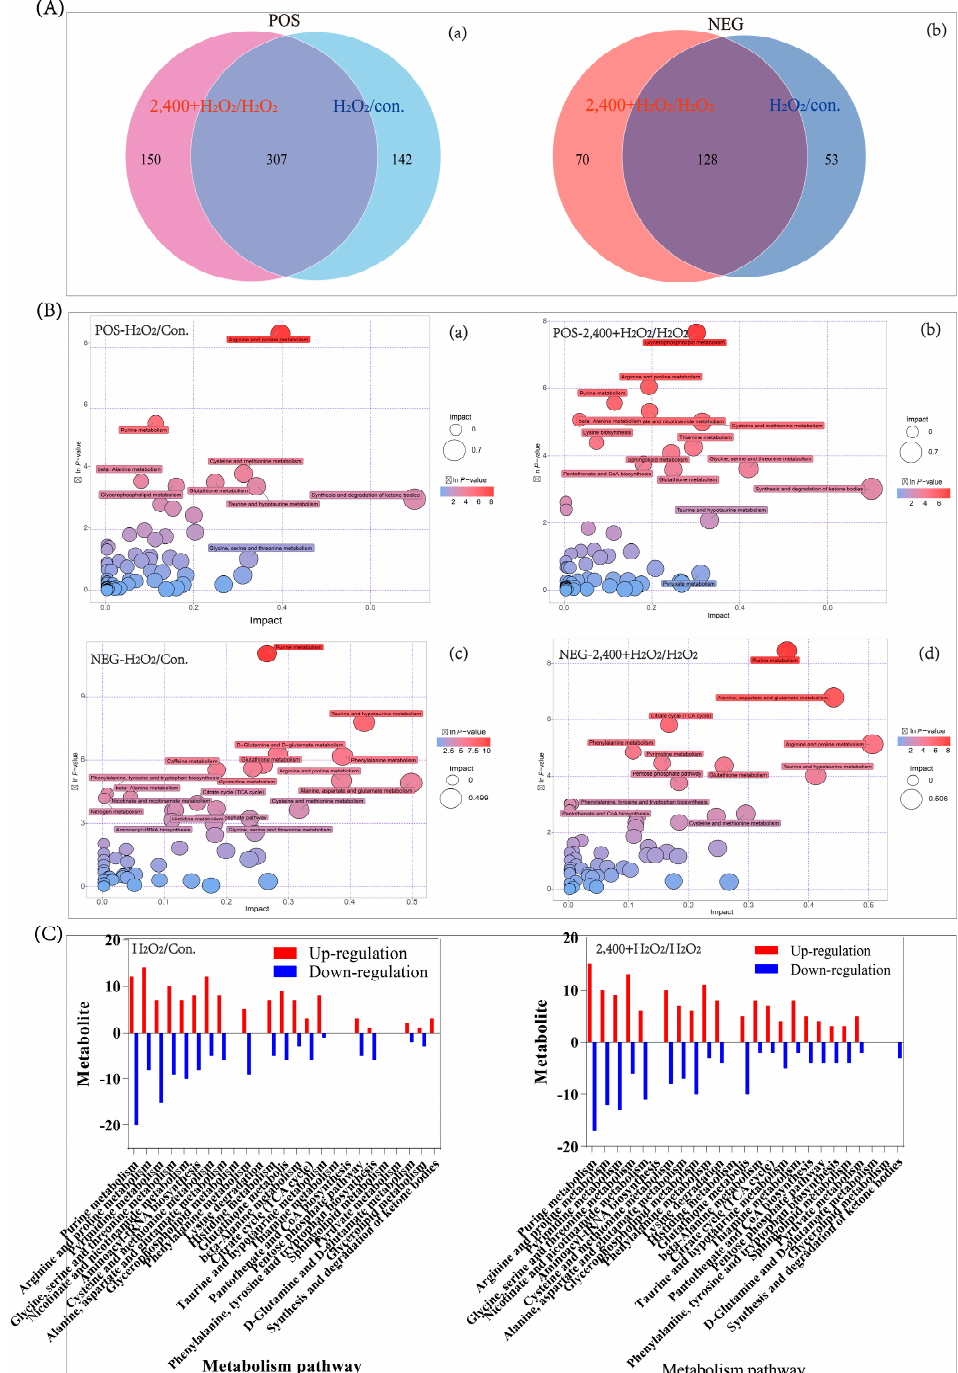
Figure 6. Metabolic pathway analysis. ( A ) Venn diagram showing differential metabolites of H 2 O 2 /Con. and chrysanthemum extract/H 2 O 2 . ( B ) Bubble plot showing the differential metabolic pathway enriched by metabolites. ( C ) Bar chart showing the differential metabolic pathway en- riched by metabolites. POS: data achieved from positive ion mode of mass spectrum; NEG: data achieved from negative ion mode of mass spectrum. Con.: control; H 2 O 2 : 7 mM H 2 O 2 ; 2400 + H 2 O 2 : 2400 μ g/mL chrysanthemum extract and 7 mM H 2 O 2 . In figure ( A ), “a” represents the positive ion mode and “b” represents the negative ion mode; In figure ( B ), “a,b” represent the positive ion mode, and “c,d” represent the negative ion mode.